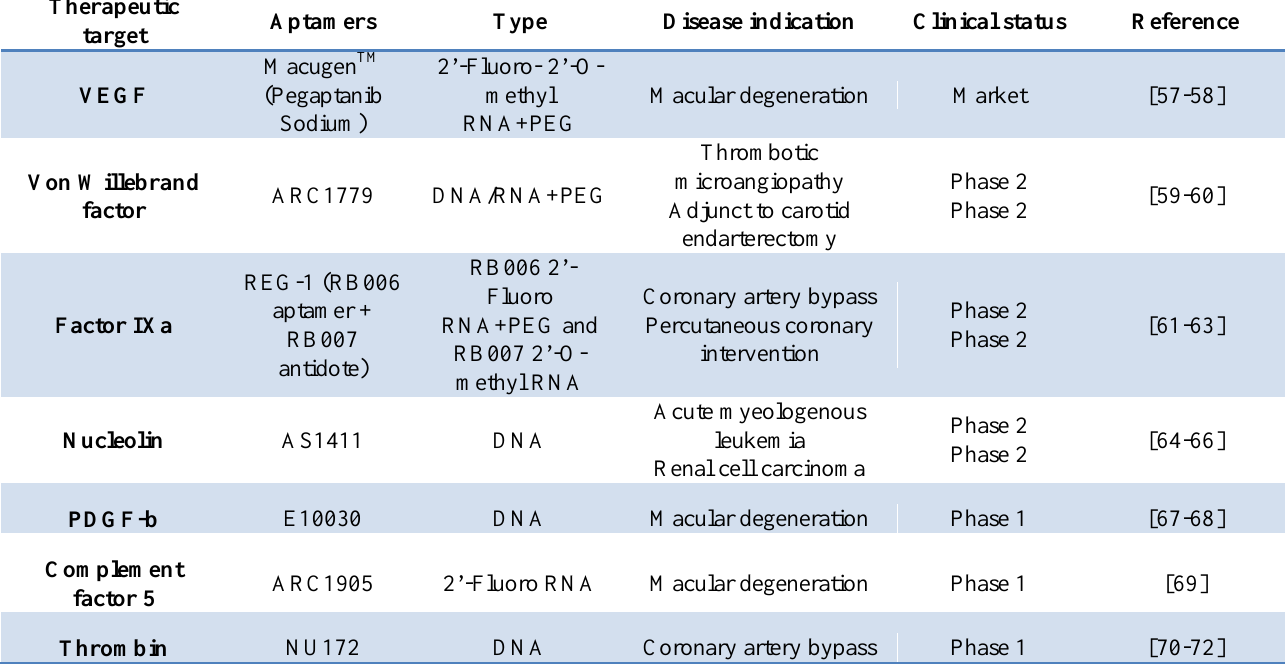
VEGF = vascular endothelial grow factor; PDGF-b = Platelet-derived growth factor B-chain; PEG = polyethylene